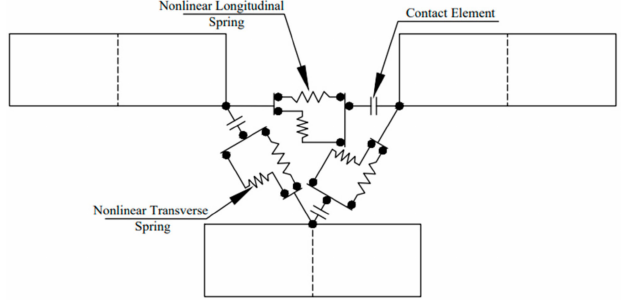
Figure 4. Brick-mortar joint